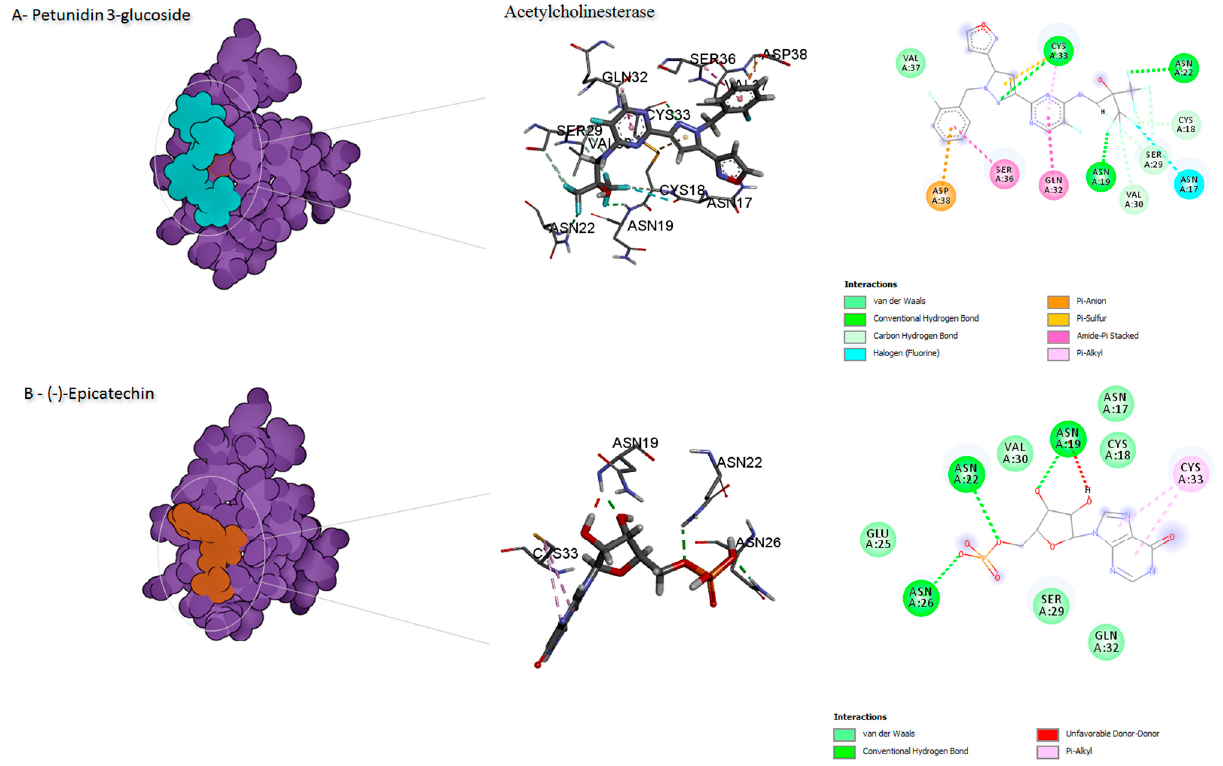
Figure 2. Predicted binding mode for acetylcholinesterase with petunidin 3-glucoside and disodium 5 ′ -inosinate.